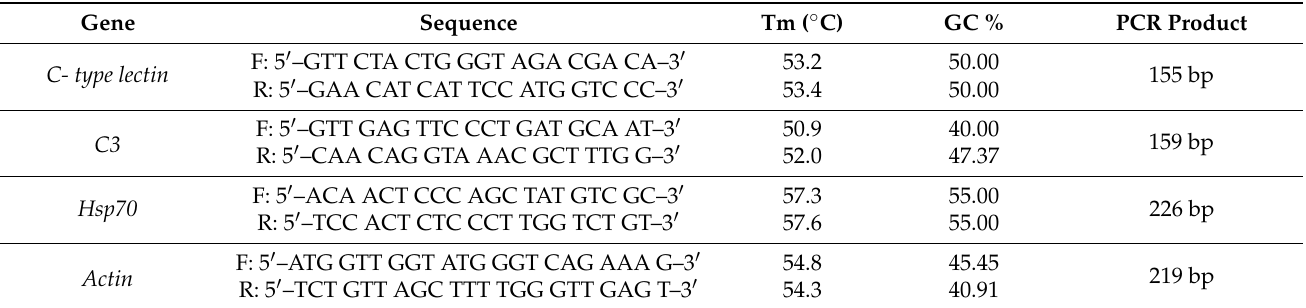
Table 1. List of genes of interest (GOIs) with primer designs. The melting temperature (Tm), the % of guanine and cytosine (GC), and the length of PCR product (bp) are also reported for each gene. Additional information of these sequences can be found in Supplementary